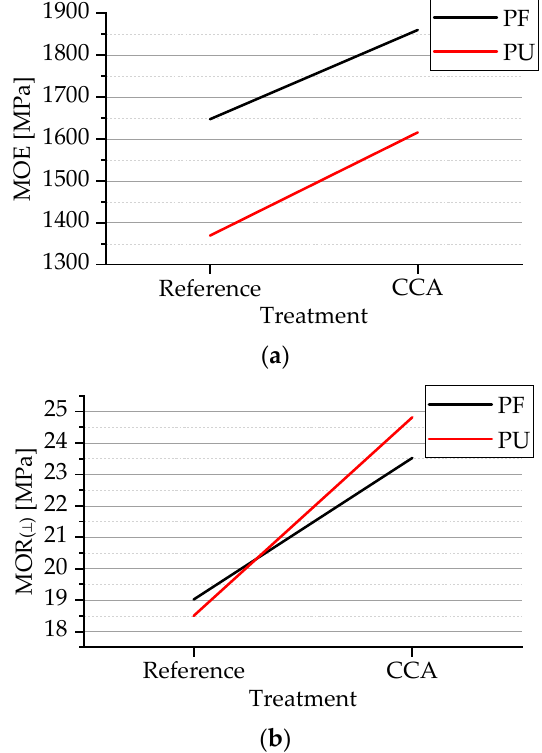
Figure 8. Interaction graphics: parallel static bending ( a ) MOE ⊥ and ( b ) MOR ⊥ .